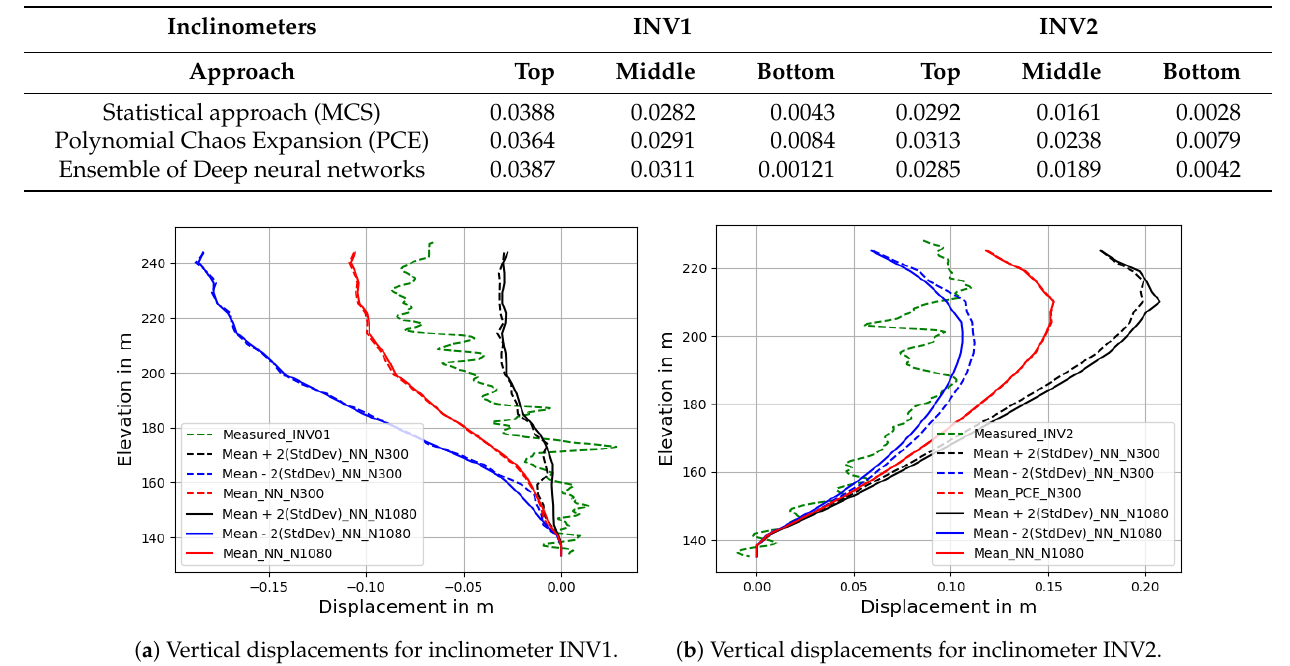
Table 2. Comparative study of standard deviation in m by numerical simulations and surrogate models for top, middle and bottom sections of the dam.